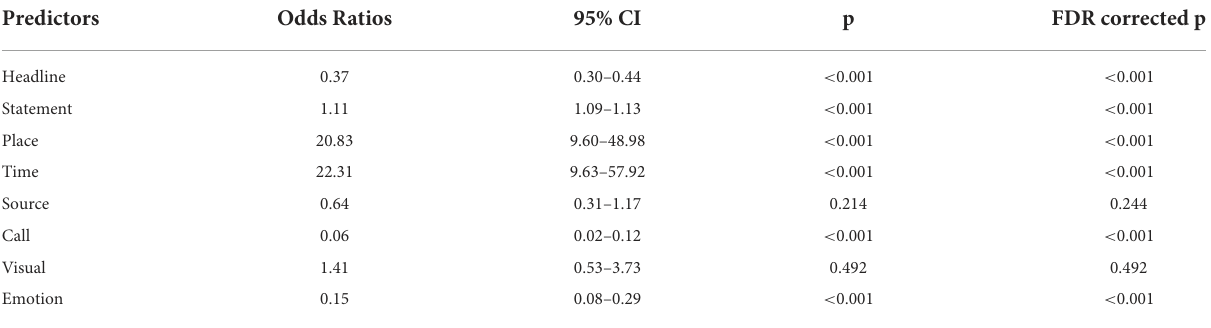
TABLE 6 Logistic regression